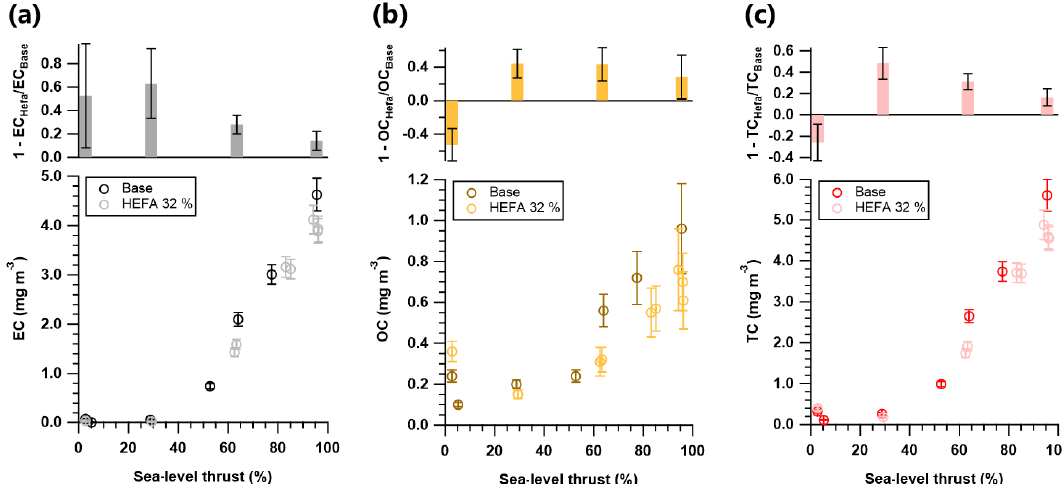
Figure 2. Thrust-dependent mass concentration and decrease with the 32% HEFA blend compared to the base Jet A-1 fuel of (a) elemental carbon (EC), (b) organic carbon (OC) and (c) total carbon (TC). Note that dark colours represent measurements with base fuel (Jet A-1), and light colours represent measurements with the HEFA blend (32%vol).